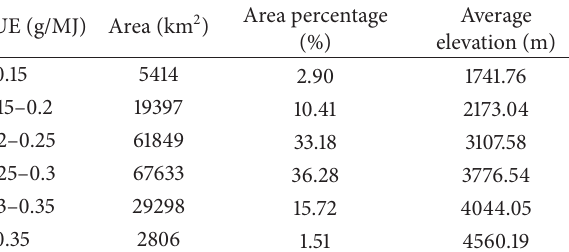
Table 4: LUE partition statistics of Sichuan grassland in 2011.